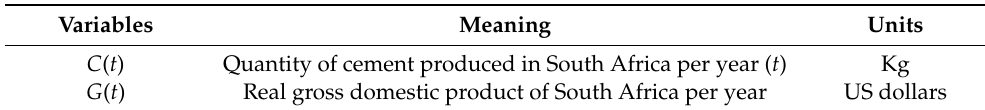
Table 2. The variables. Variables